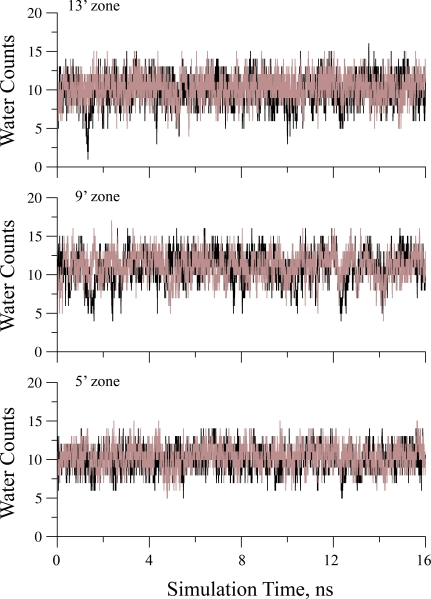
Number of Water Molecules in Three 6 Å-Layered Zones Centered at TMD2 Positions 5′, 9′, and 13′ Plotted against Simulation Time for the Restrained StructureBlack traces represent the simulation at −100 mV, and the brown traces represent the simulation at −200 mV.